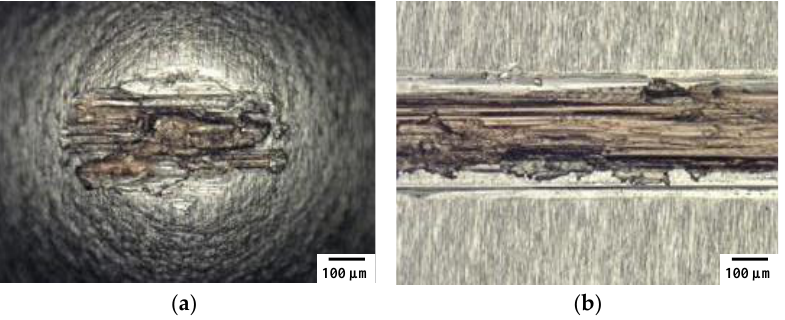
Figure 11. Micrographs of the worn surfaces of ( a ) the embossed specimen and ( b ) the plate specimen (t = 0.2 mm, Ag plating 1 µm, v = 200 mm/min, n = 50 times).